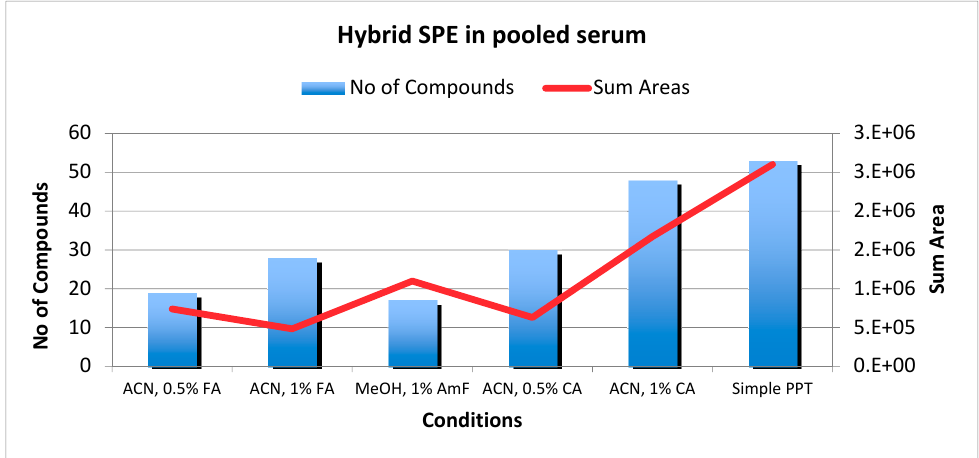
Figure 2. Plot showing the number of detected compounds (bars) and the sum of their areas (line) in the extract of pooled serum sample at different Hybrid SPE conditions.